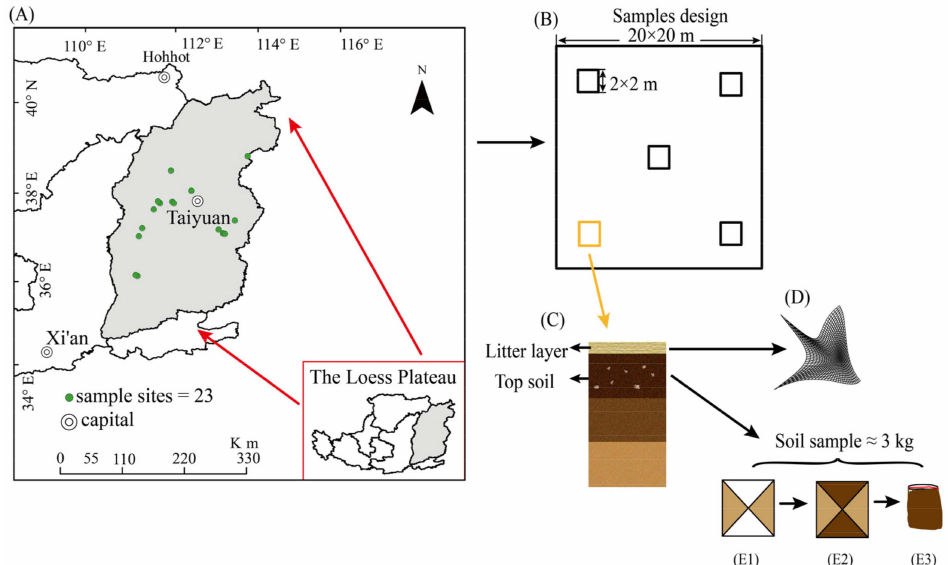
Figure 2. Graphs of sample collection for this research. Due to the limited area of natural P. tabulae- formis forests in Shanxi Province, certain sample sites were near together or overlapped in the plot.